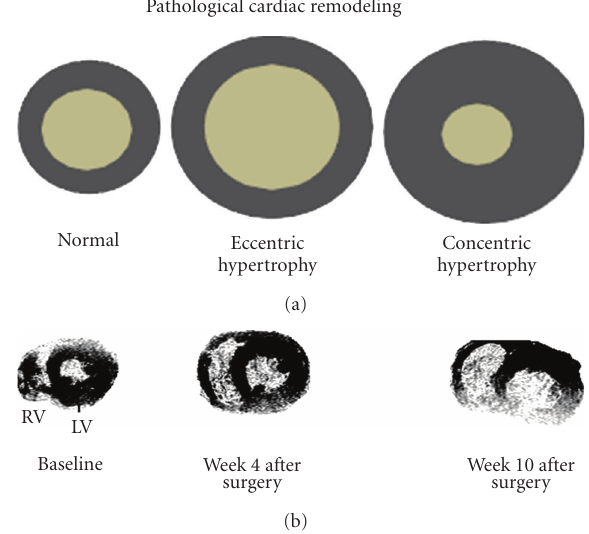
Figure 3: Cardiac hypertrophy expressed as heart weight/body weight ratio (HW/BW%) in rats with compensated and decompen- sated CHF, one week after the placement of AV fistula. ∗ P < . 05 versus sham-operated rats; # P < . 05 versus compensated rats with AV fistula. Values are means ± SEM.